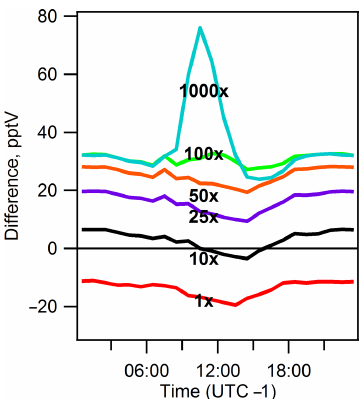
Figure 4. The difference between measured and modelled of NO x at CVO during summer months when photolysis of nitrate is con- sidered. The rate of particulate nitrate photolysis has been scaled to the rate of HNO 3 photolysis by factors of 1, 10, 25, 50, 100, and